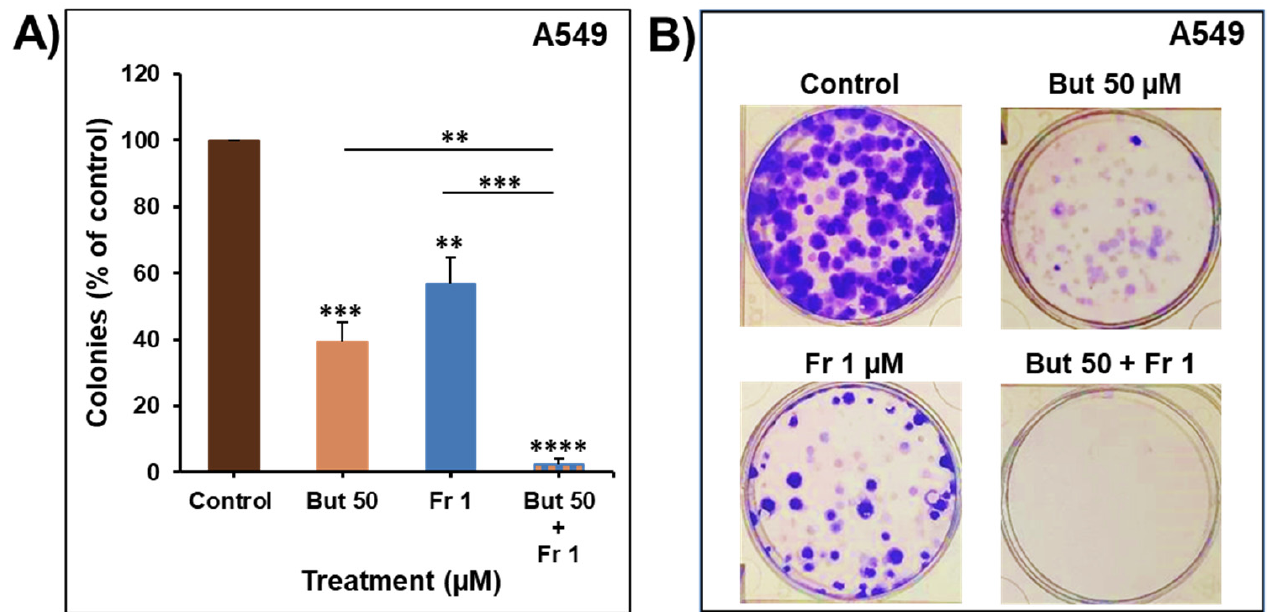
Figure 7. Impact of butein in combination with frondoside-A on A549 colony growth after 14 days of treatment ( A , B ). Experiments were repeated three times. Columns represent means; bars represent S.E.M. The statistical significance is compared to the control except for the specified lines. ** Significantly different at p < 0.01, *** Significantly different at p < 0.001, **** Significantly different at p < 0.0001.